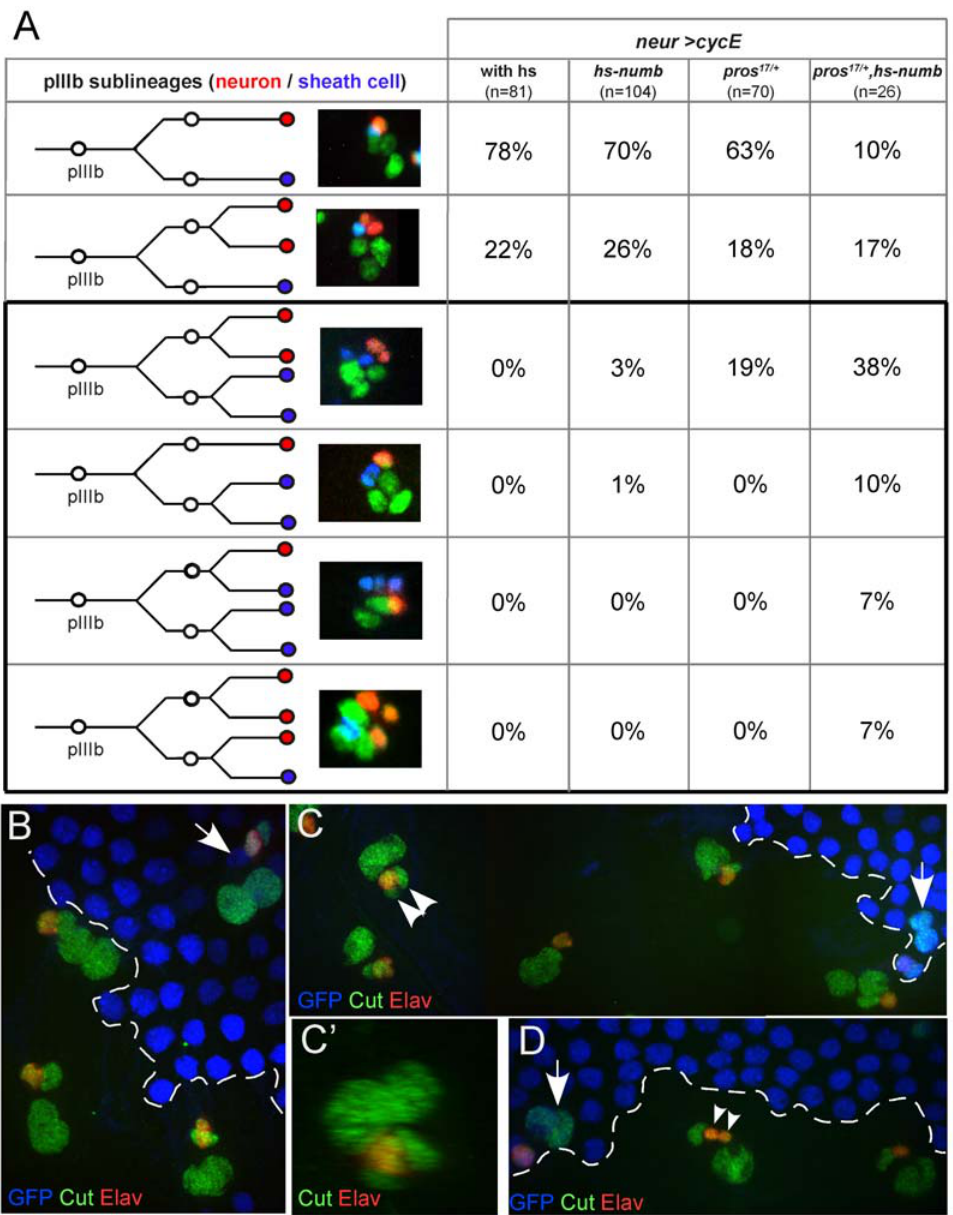
Figure 6. N and Pros cooperate to prevent extra mitoses in the sheath cell. (A) pIIIb sub-lineages were determined combining time lapse imaging and immunodetection in neur . CycE pupae alone or combined with hs-numb , pros 17/ + and hs-numb , pros 17/ + . Neurons and sheath cells were identified by ELAV (red) and Pros (blue) immunoreactivity. Cells of the bristle lineage were revealed using an anti-GFP (green) antibodies (UAS- H2B::YFP in all cases). The percentages indicate the proportion of each lineage in the different experimental conditions. The black box highlights the lineages where the sheath cell divides. The frequency of extra sheath cell division increased after combined reduction of Pros and N activity. (B–D) pros 17 clonal analysis in control (B) and N ts/ + (C,D) backgrounds. Nota from pupae maintained at 30 u C (restrictive temperature). Clones are detected by the lack of GFP staining (blue). Sensory organs and neurons are identified with cut (green) and ELAV (red) immunoreactivity respectively. (B) As in pros heterozygous tissue (arrows in B–D), sensory organs inside pros 17 null clones are formed by four cells (two big pIIa and two small pIIIb daughter cells). (C,D) in N ts/ + background, several sensory organs inside pros 17 clones harbour three pIIIb daughter cells. Either one neuron and two sheath cells (arrowhead in C, and slightly tilted to reveal the two pIIa daughter cells in C’), or one sheath cell and two neurons (arrowheads in